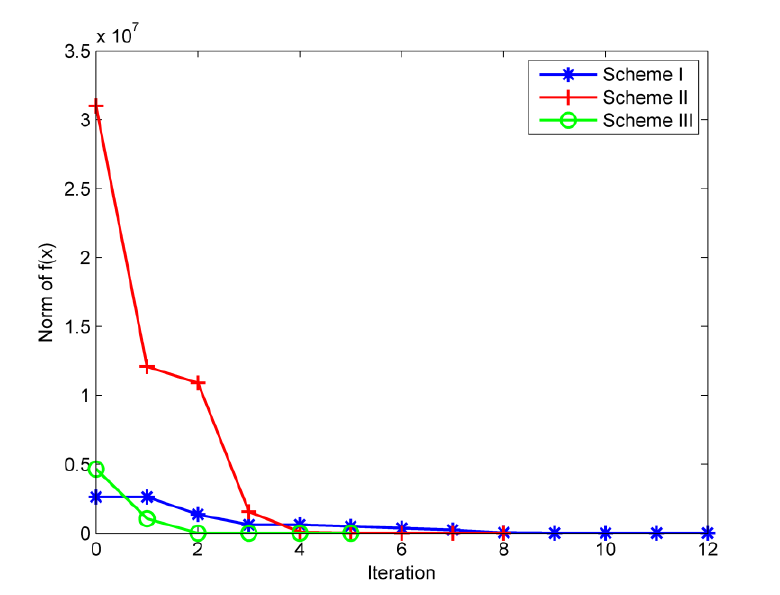
Figure 17. The iterative process using the different initial model